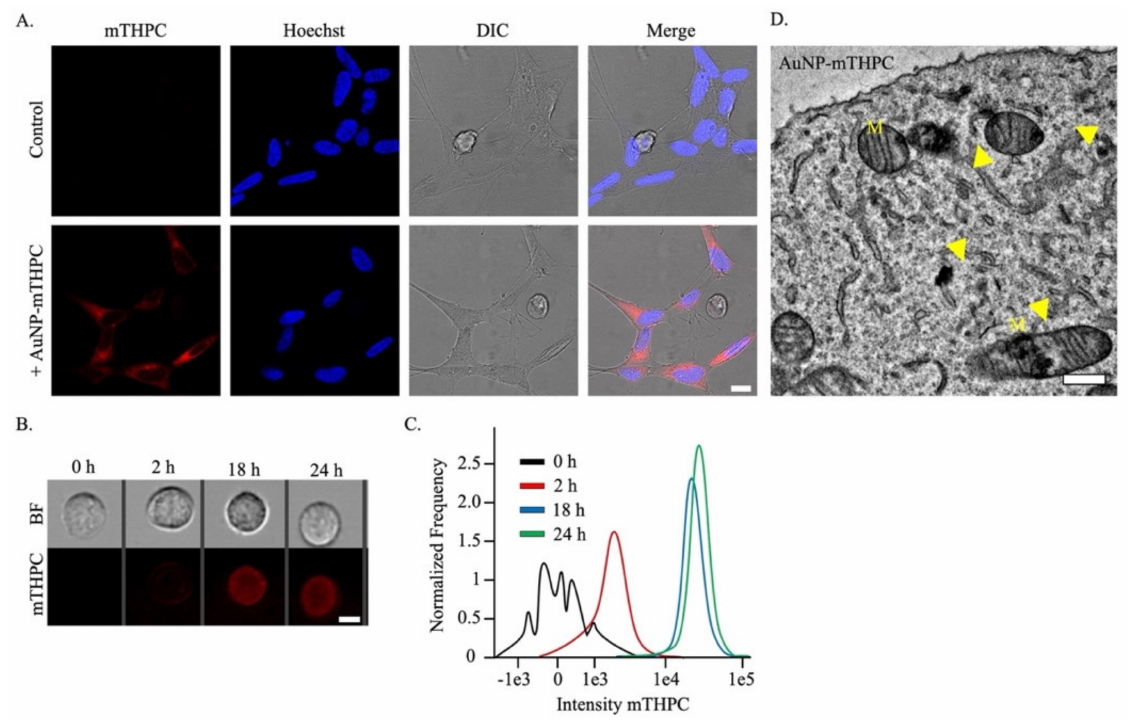
Figure 3. Localization of AuNP–mTHPC in live SH-SY5Y cells. ( A ) Images of SH-SY5Y cells incubated with 1.2 µ m of the AuNP–mTHPC complex (red). Nuclei are counterstained with Hoechst (blue). Scale bar = 10 µ m. ( B ) Images captured by ImageStreamX on the bright field (BF) and mTHPC (red) fluorescence channels, after 0, 2, 18, and 24 h of AuNP–mTHPC incubation. Scale bar = 7 µ m. ( C ) Dynamics of AuNP–mTHPC entry into the cells measured by ImageStreamX. A histogram of the pixel-by-pixel intensity of mTHPC from SH-SY5Y cells ( n = 1000) incubated with 1.2 µ M of AuNP– mTHPC. ( D ) Electron micrograph of SH-SY5Y cell after incubation with 1.2 µ m of the AuNP − mTHPC complex. The image shows the intracellular AuNP–mTHPC complex scattered through the cytoplasm and inside multiple mitochondria (M). Scale bar = 0.5 µ